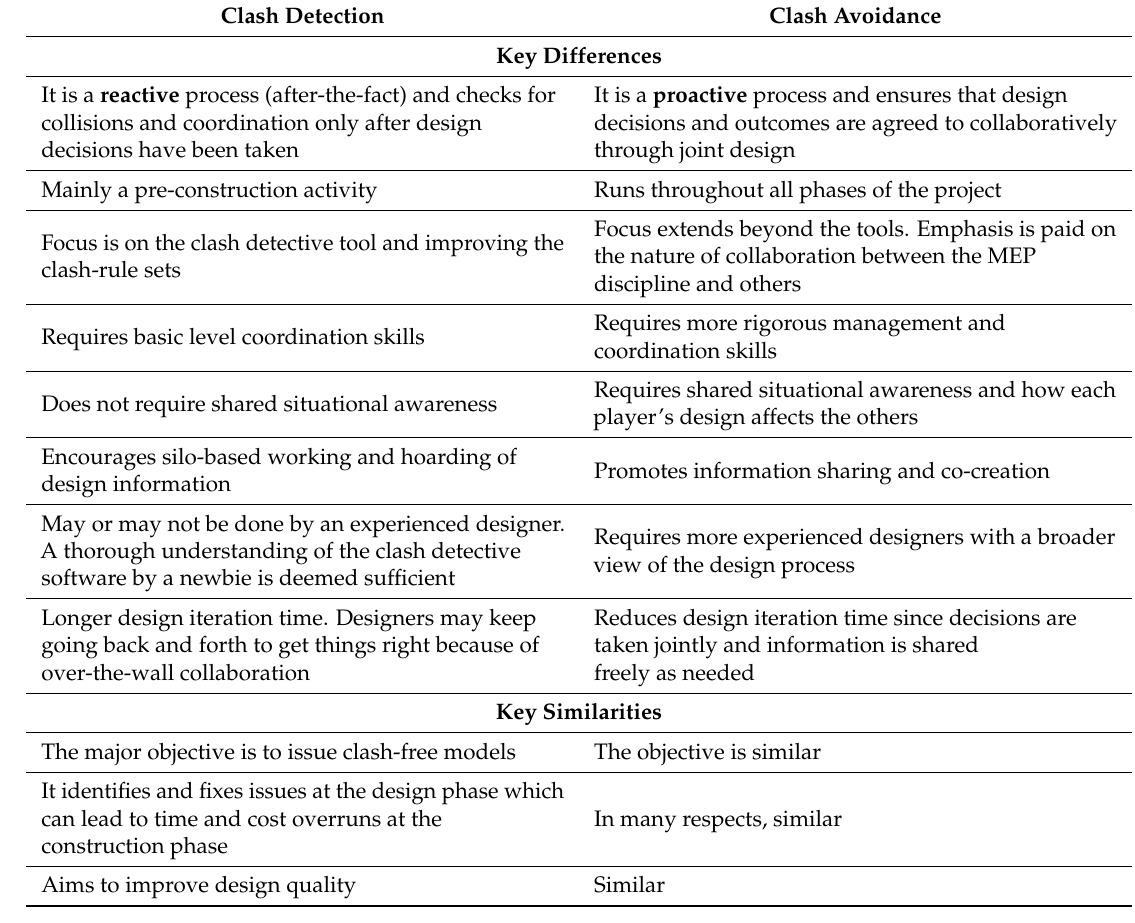
Table 3. Summary of variables relationship between clash detection and clash